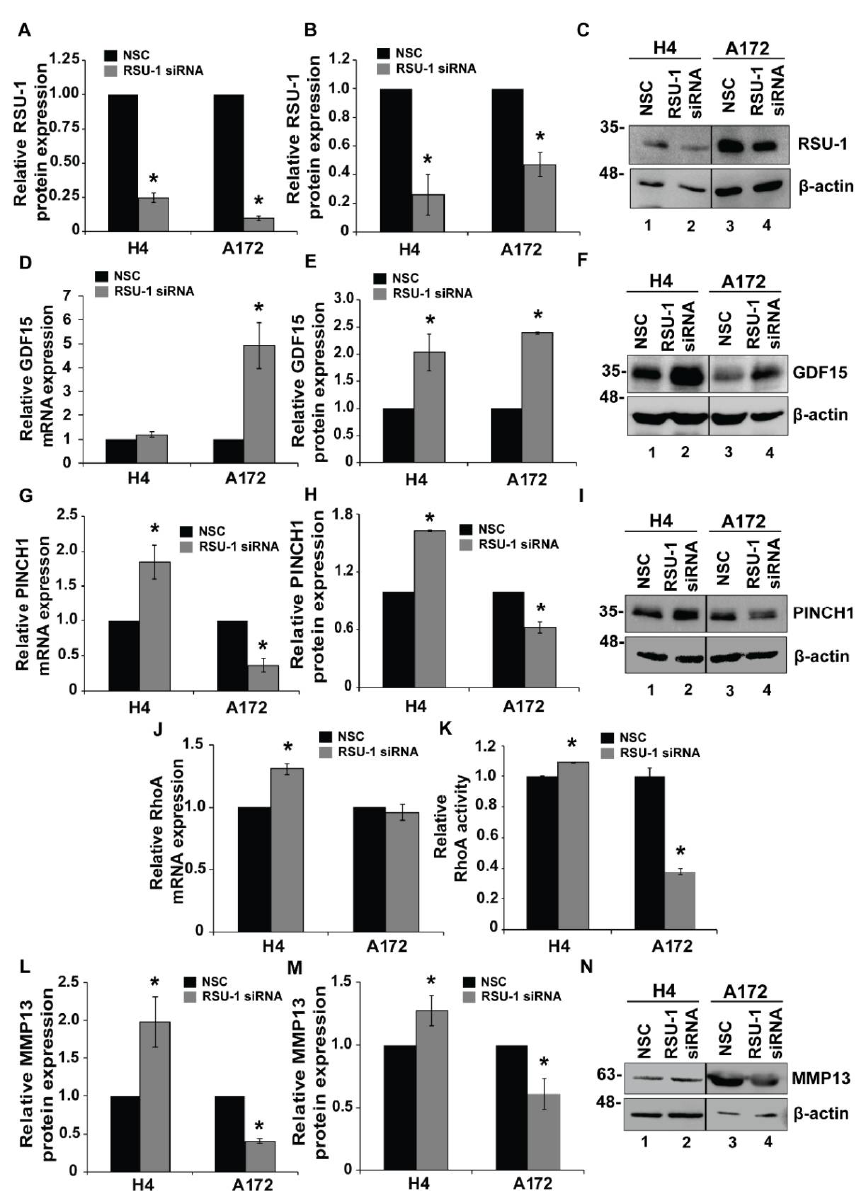
Figure 4. RSU-1 silencing upregulates GDF15 expression and regulates PINCH1 , RhoA and MMP13 expression. ( A , D , G , J , L ) Relative mRNA expression of RSU-1 , GDF15 , PINCH1 , RhoA and MMP13 respectively in the H4 and A172 cell lines upon RSU-1 silencing. Four independent real-time PCR experiments were performed and data were analyzed using the ΔΔCt method, while non-specific control (NSC) treated cells were used as the calibrator sample for each cell line. ( B , E , H , M ) Relative RSU-1, GDF15, PINCH1 and MMP13 protein expression respectively after treatment with NSC or RSU-1 siRNA for 48 h in H4 and A172 cells. Quantification was performed using the NIH ImageJ software and the mean band intensity was calculated from two different immunoblots. ( C , F , I , N ) Representative pictures from Western blot displaying RSU-1, GDF15, PINCH1 and MMP13 expression at the protein level after RSU-1 silencing for H4 and A172 cell lines. ( K ) Relative RhoA activity 48 h post RSU-1 silencing for H4 and A172 cell lines. Asterisks indicate a statistically significant difference ( p < 0.05) compared to NSC data.